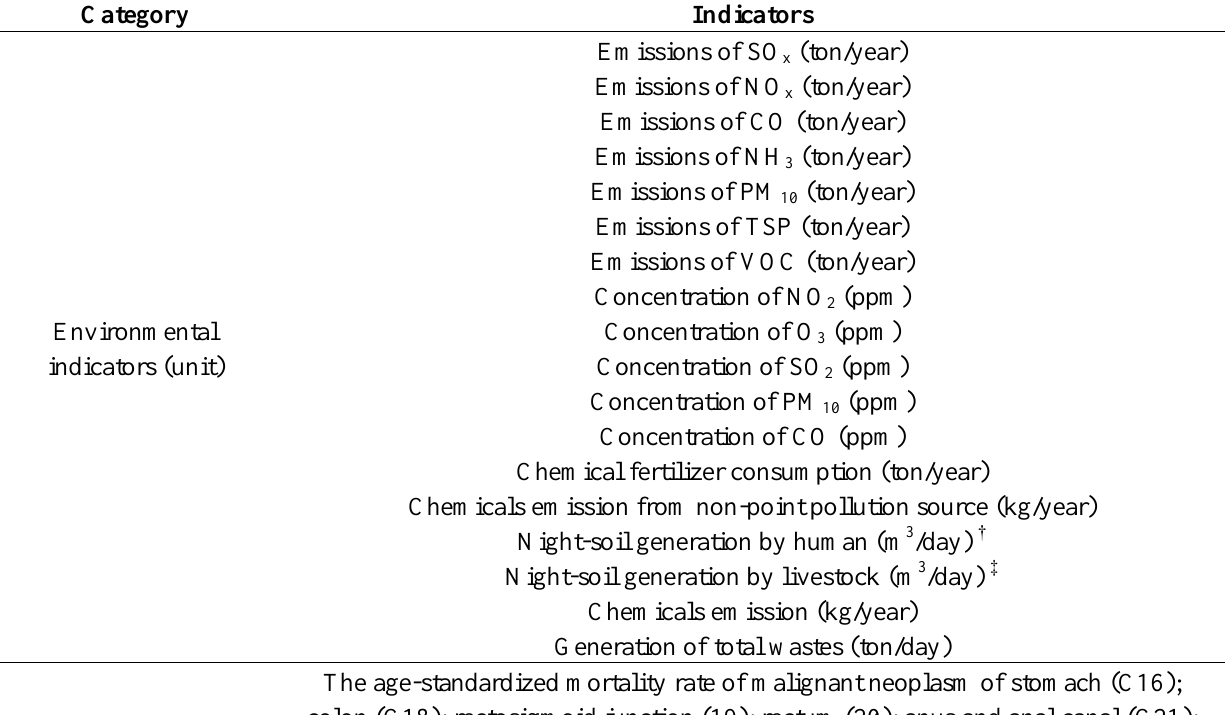
Table 1. Indicators selected for the